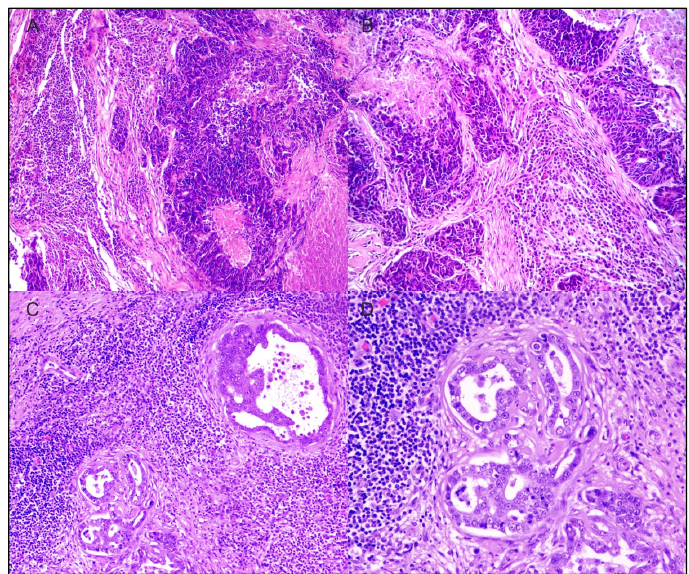
Figure 3. ( A , B ) Canine mammary comedocarcinoma histological grade III, hematoxylin and eosin. ( A ) The tumoral stromal area is massively effaced by tumor infiltrating lymphocytes (TILs), 10×; ( B ) higher power magnification showing mainly lymphocytes and plasma cells among TILs, 20×. ( C , D ) Feline mammary simple tubular carcinoma, histological grade II, hematoxylin and eosin. The stromal area is strongly infiltrated by TILs, 10×; higher magnification depicting mainly small lymphocytes among TILs.